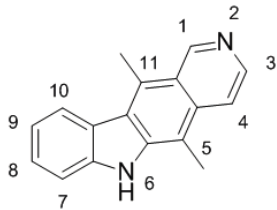
Figure 1. Ellipticine. Numbers 1–11 indicate locations of carbon and nitrogen atoms in the ellipticine